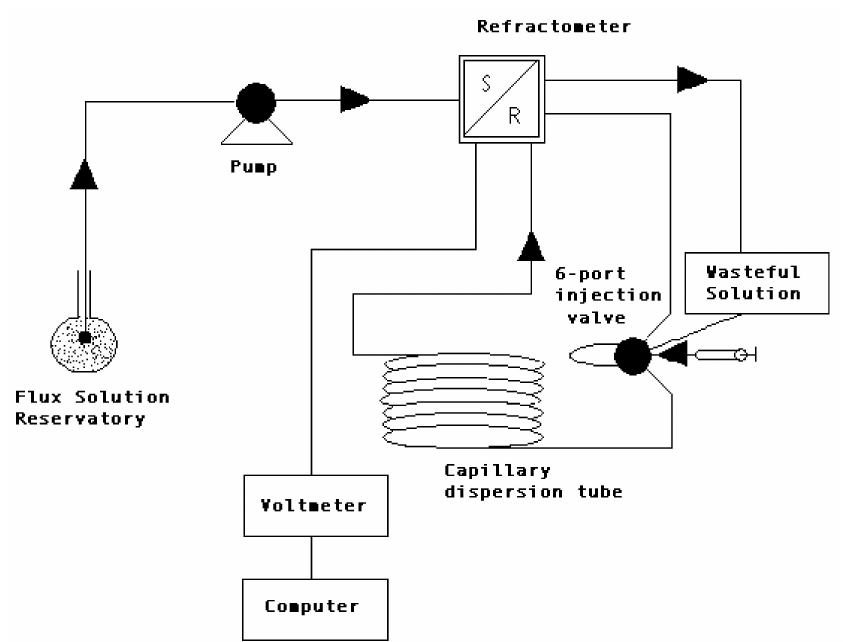
Figure 2. Schematic representation of the Taylor dispersion technique [25]. One of the main techniques used in the characterization of diffusion is the Taylor dispersion technique (accuracy: 1%–2%), a rapid and convenient flow technique to measure mutual diffusion in solutions. Multicomponent mutual diffusion (chemical interdiffusion) coefficients for both electrolyte and nonelectrolyte drugs and carriers have been determined by using the Taylor dispersion technique. This technique is based on the dispersion of small amounts of solutes injected into carrier solutions flowing through a capillary tube. The combined action of radial diffusion and convection along the tube axis causes the injected solute samples to spread out, producing Gaussian concentration profiles. Mutual diffusion coefficients, including cross-coefficients describing coupled transport, are calculated from refractive index profiles measured across the dispersed solute peaks at the outlet of the dispersion tube, employing conventional pulse-injection Taylor experiments and step-function techniques developed for studies